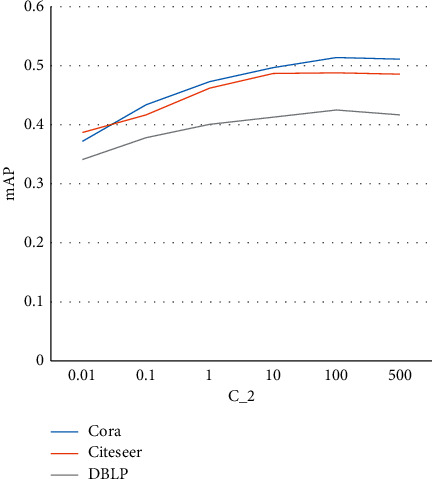
Sensitivity analysis of C2.